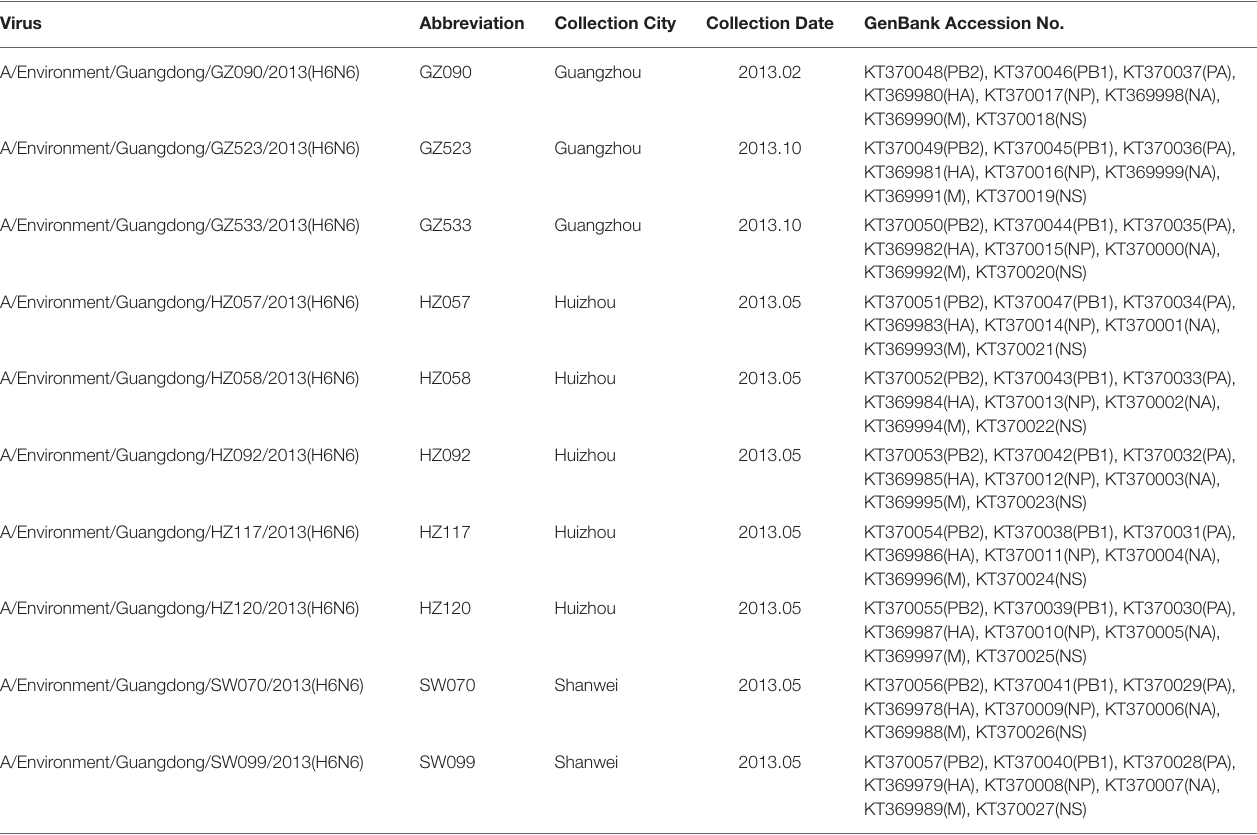
TABLE 1 | Isolation of H6N6 subtype viruses from LPM in Guangdong in 2013.